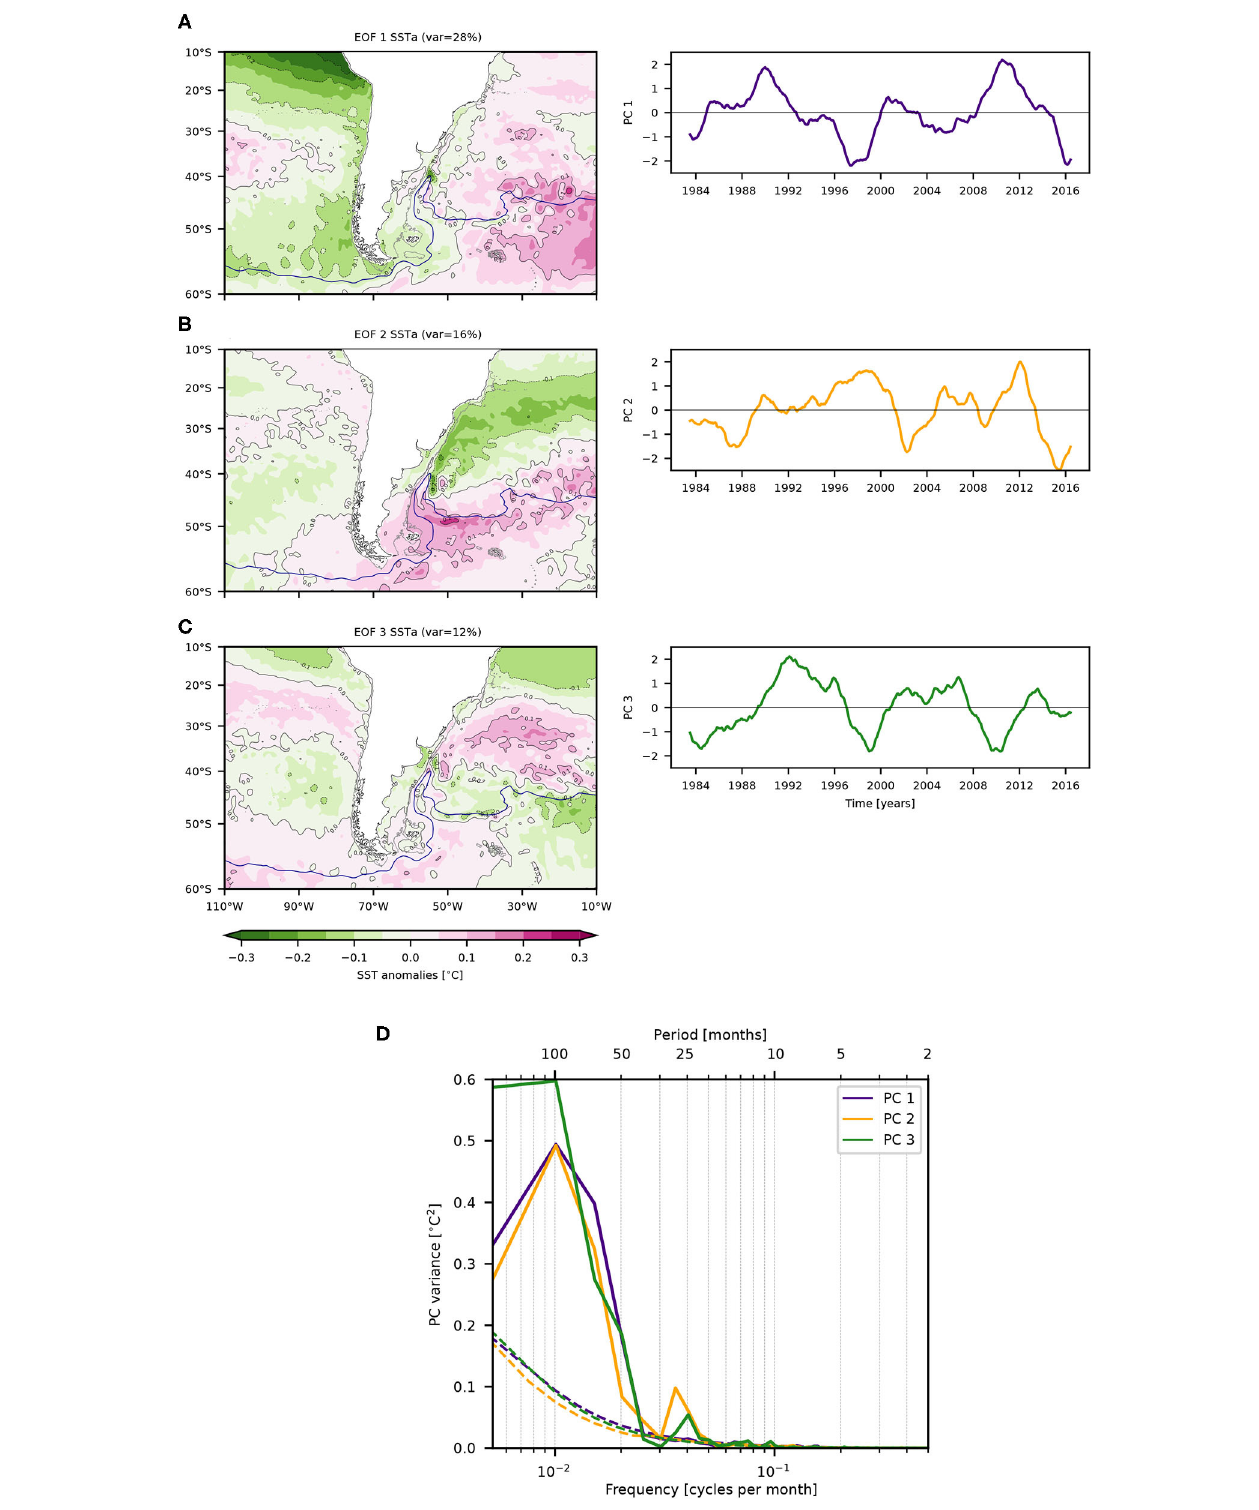
FIGURE 9 | (Left) First three (A–C) leading EOF of filtered and detrended SSTa estimated over the period 1982–2017 (Section 3.3) and (right) Principal Components (PC) time series of each EOF in normalized units (see Section 2.4 for methodology). The solid gray line in the EOF indicates the 200 m isobath and the solid dark blue line indicates the mean location of SAF (identical to Figures 2 , 4 ). (D) Variance preserving Welch spectrum of the corresponding PC time series for the three leading EOF (solid violet, orange and green lines, respectively). The power spectral density of red noise for each spectrum is indicated by the dashed lines (see Section 3.3).